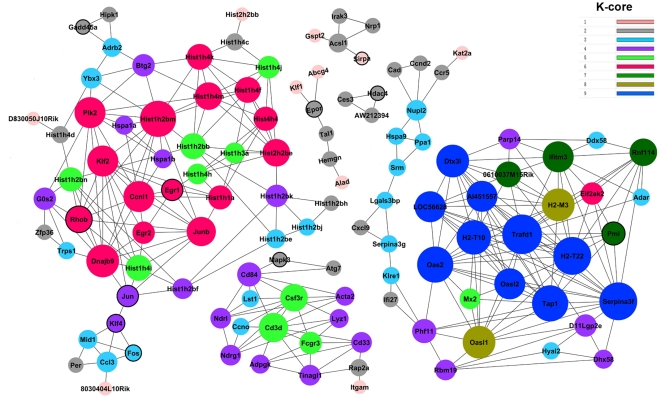
Gene co-expression network.Genes contained in significant GO terms were analyzed and identified by gene co-expression network with the k-core algorithm. Nodes represent the gene (black-cycled node represents gene also appeared in the text-mined gene list); edges indicate the interaction between genes. All the nodes were marked with k-core values. Genes with higher k-core values are more centralized in the network and have a stronger capacity of modulating adjacent genes.